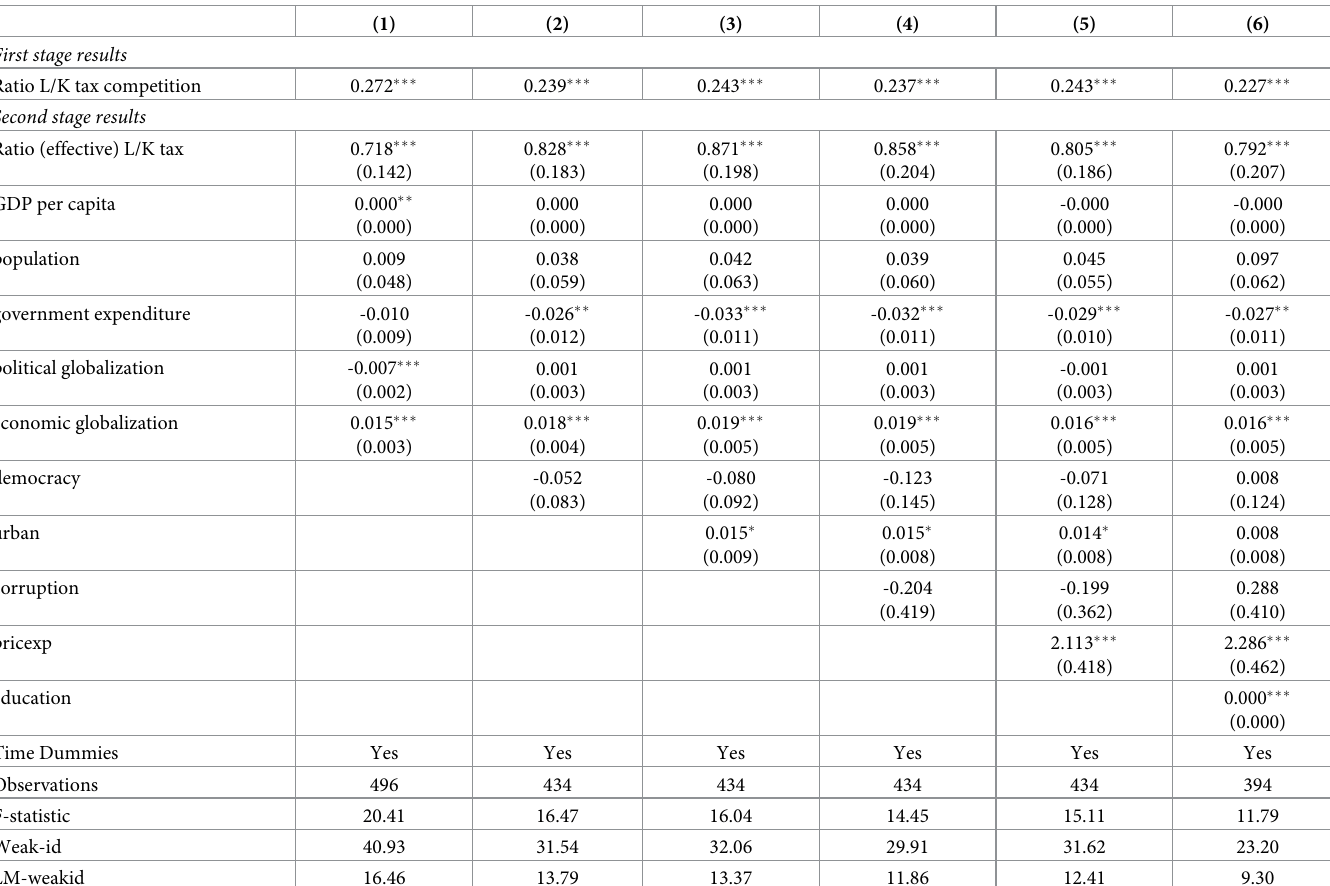
Table 5. The impact of taxation on economic sophistication: Ratio of (effective) labor to (effective) capital tax